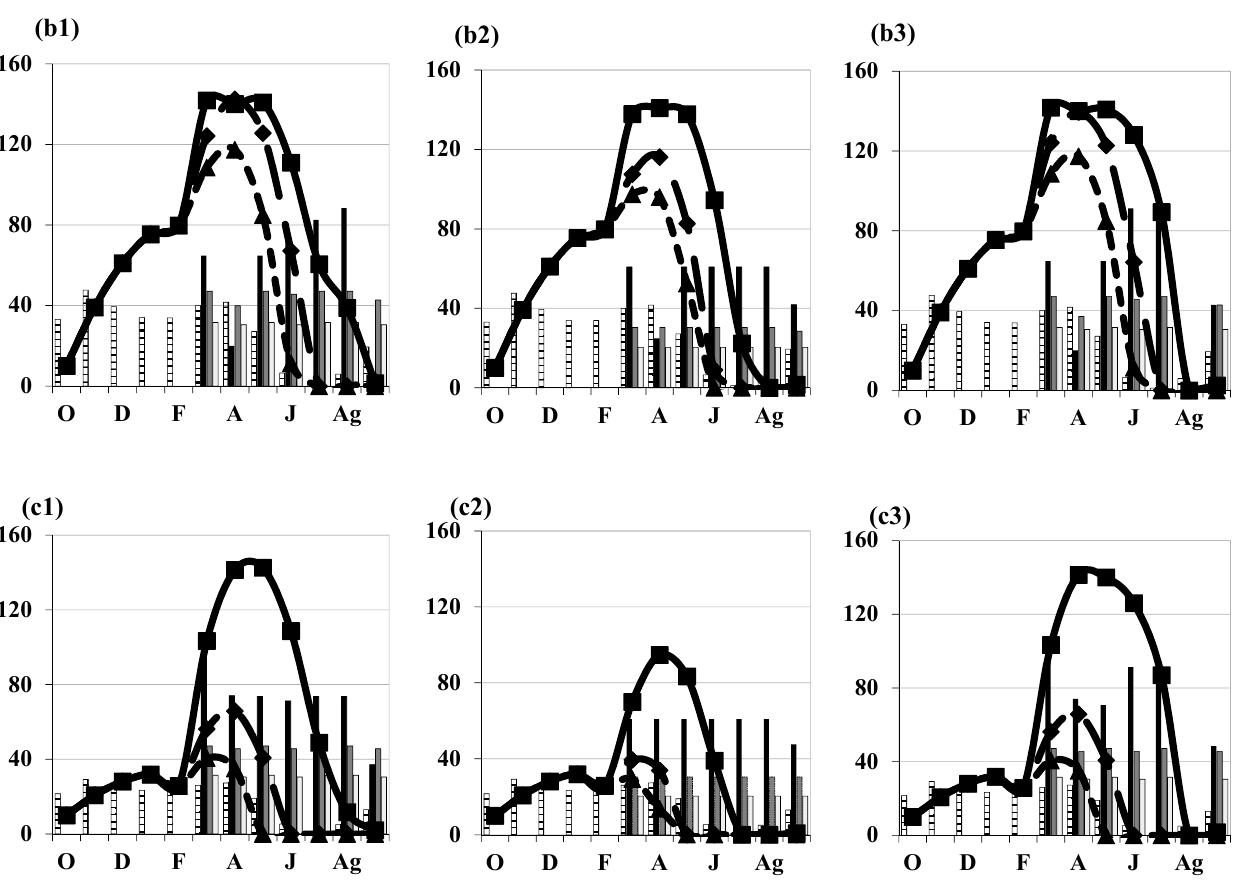
Figure 5. Patterns of the soil water reserves in three strategies: daily irrigation ( a1 , b1 , c1 ), irrigation 20 days per month ( a2 , b2 , c2 ), and no irrigation in August ( a3 , b3 , c3 ), under maximum ( a1 - a2 - a3 ), average ( b1 - b2 - b3 ), and minimum rainfall conditions ( c1 - c2 - c3 ). Solid line, 1-sector strategy; long dashed line, 2-sector strategy; dashed line, 3-sector strategy. Bars with a square pattern represent effective rainfall; solid bars represent irrigation in the 1-sector strategy; clear bars represent irrigation in the 2-sector strategy; white bars represent irrigation in the 3-sector strategy. The horizontal x-axis (or abscissa axis) represents variations in the soil water reserves during the period of the irrigation campaign. The vertical y-axis (or ordinate axis) represents rainfall and irrigation.